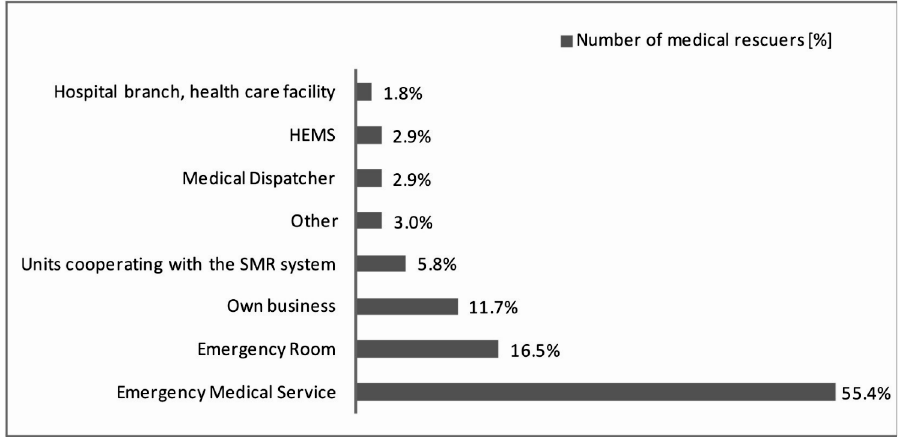
Figure 2. Percentages of the surveyed paramedics concerning their workplaces